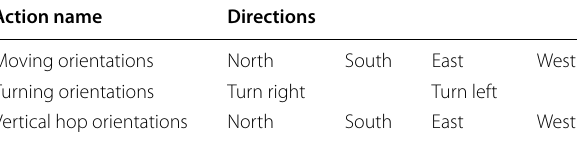
Table 3 The action